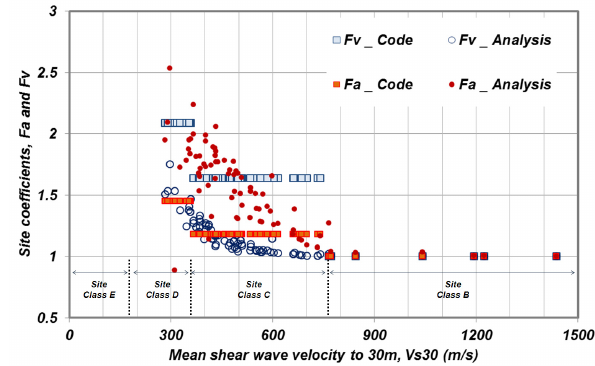
Fig. 8. GIS based geotechnical information system for the earth- quake level of 1000yr return period: (a) the bedrock depth; (b) nat- ural site period; (c) peak ground acceleration; (d) short-period site amplification coefficients, Fa.